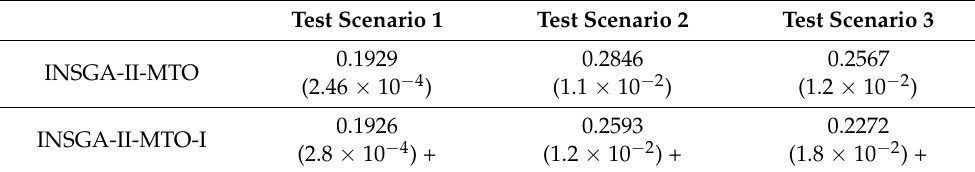
Table 4. HV results of the INSGA-II-MTO and INSGA-II-MTO-I.